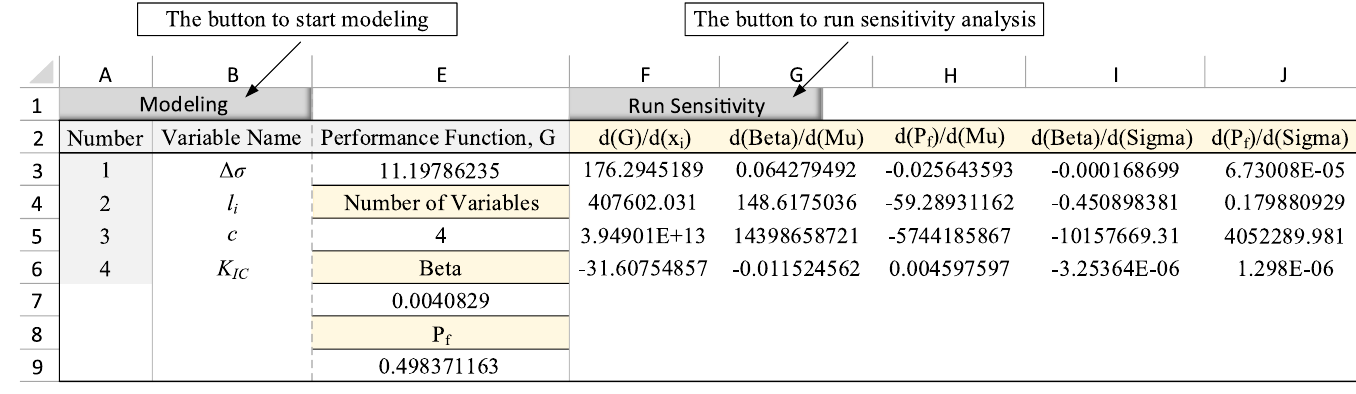
Fig 6. The output table in the spreadsheet for the example 2.